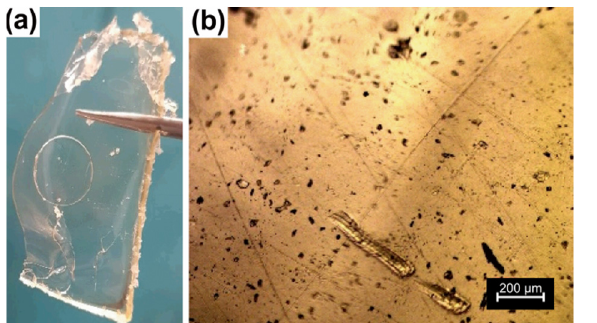
Figure 1. Hydrogel formation schema.